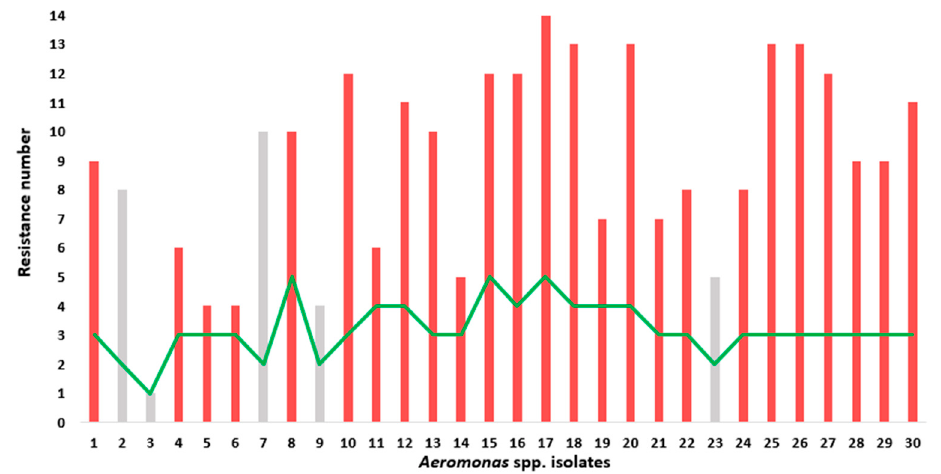
Figure 5. Multidrug-resistance (MDR) in the Tua River, where 25 out of the 30 Aeromonas isolates (red bars) were resistant to three or more antibiotic classes. The grey bars indicate no MDR isolates (5 out of the 30). The green line represents the number of antibiotic classes of resistance.